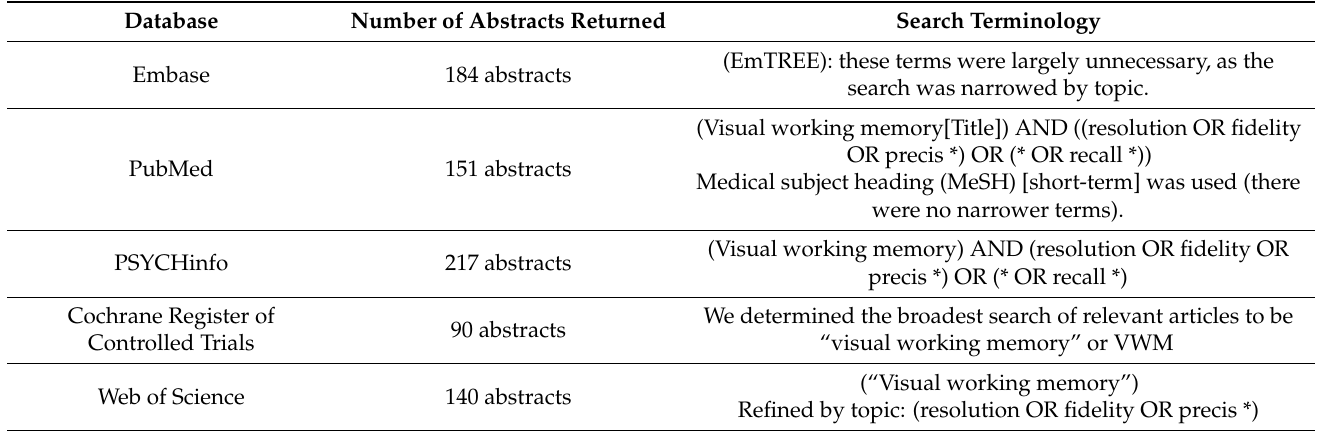
Table 1. Summary of the number of abstracts returned for each of the five databases using the search terminology used in the right-most